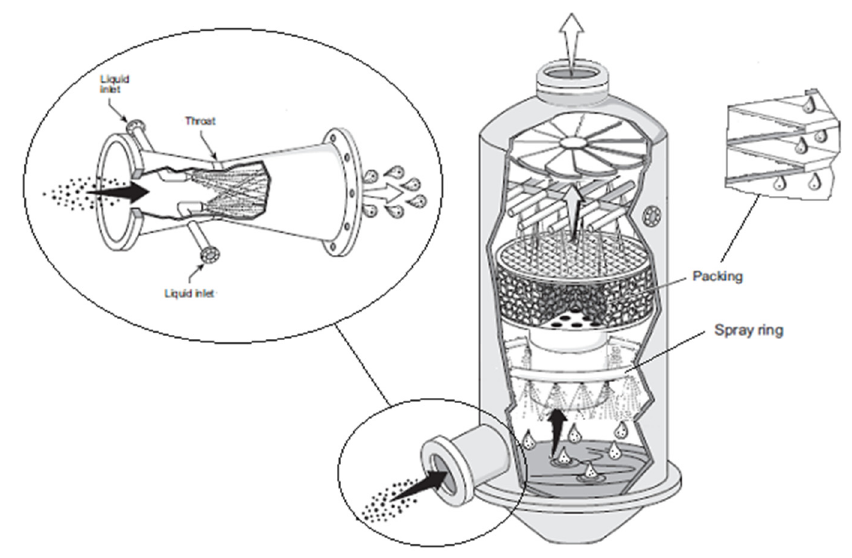
Figure 1. Schematic representation of the three-stage air treatment system of APA (Air Pollution Abatement) technology. The weak Venturi ejectors, the spray tower and the variable deposition stack are represented.